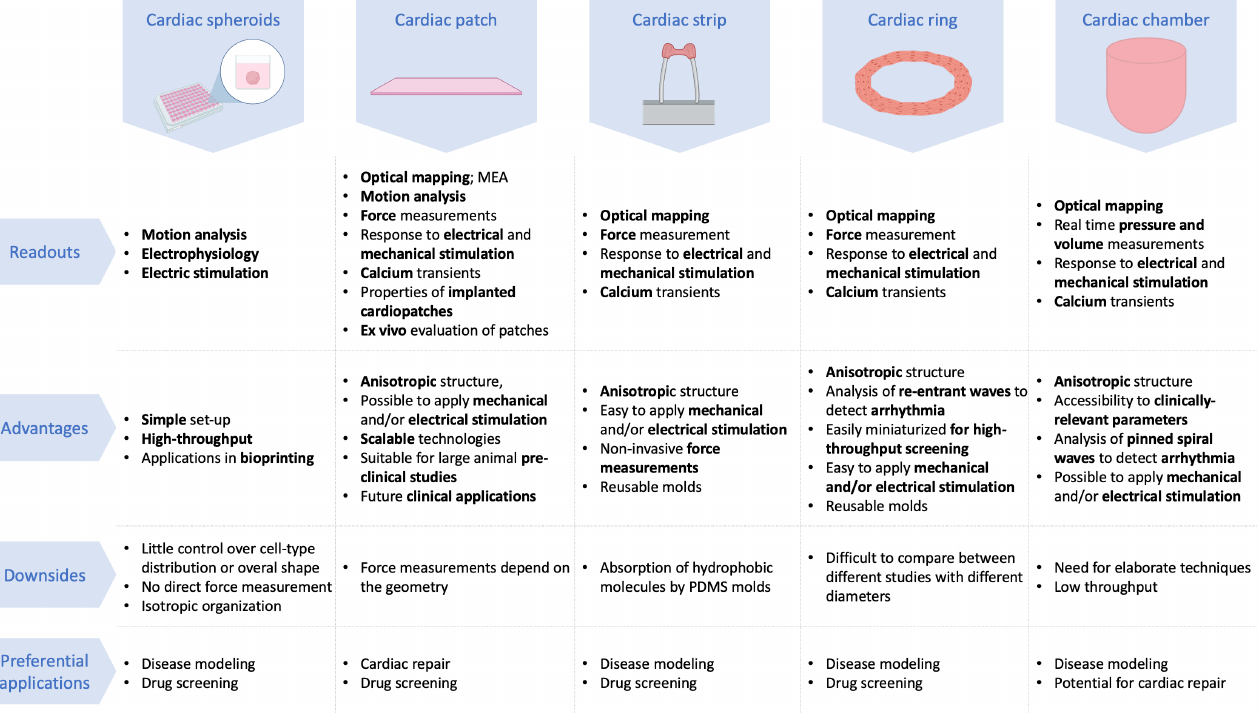
Figure 3. Different geometries for engineered cardiac tissues, their readouts, advantages and downsides, and their preferential